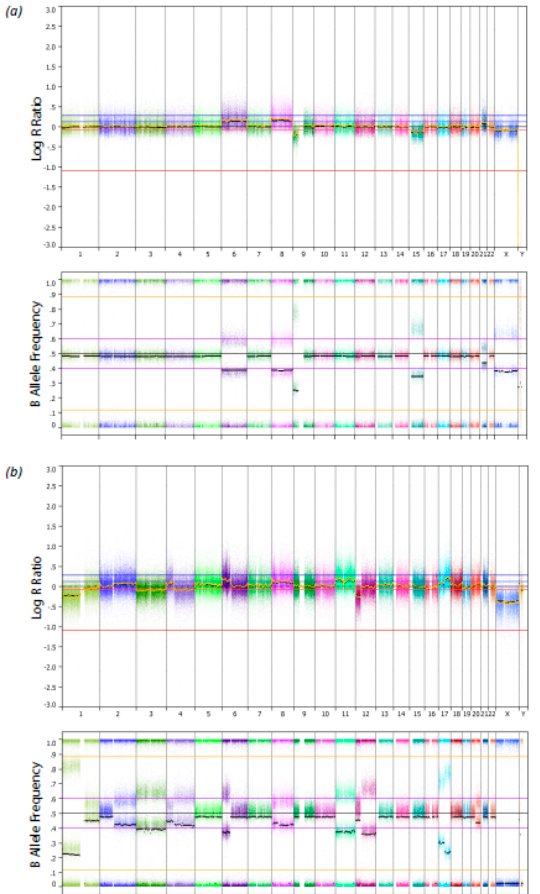
Figure 1. Single nucleotide polymorphism (SNP) array profile with the B-allele frequency from two uveal melanoma samples with an SRSF2 mutation. On the x-axes the chromosomes are displayed. ( a ) Uveal melanoma 1 (UM1). ( b ) Uveal melanoma 2 (UM2).